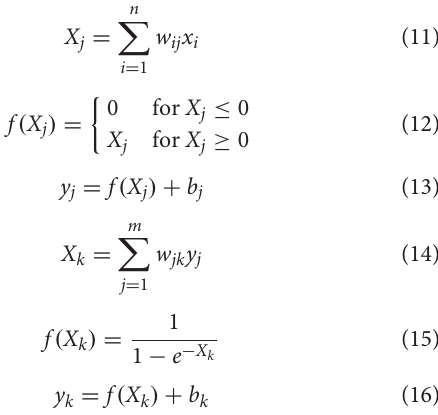
standardize the input features. The features were standardized